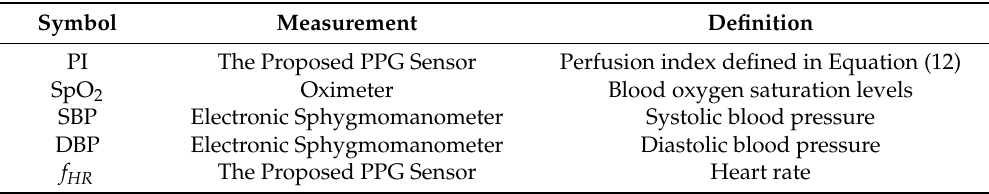
Table 1. Five input features for the support vector machine (SVM)